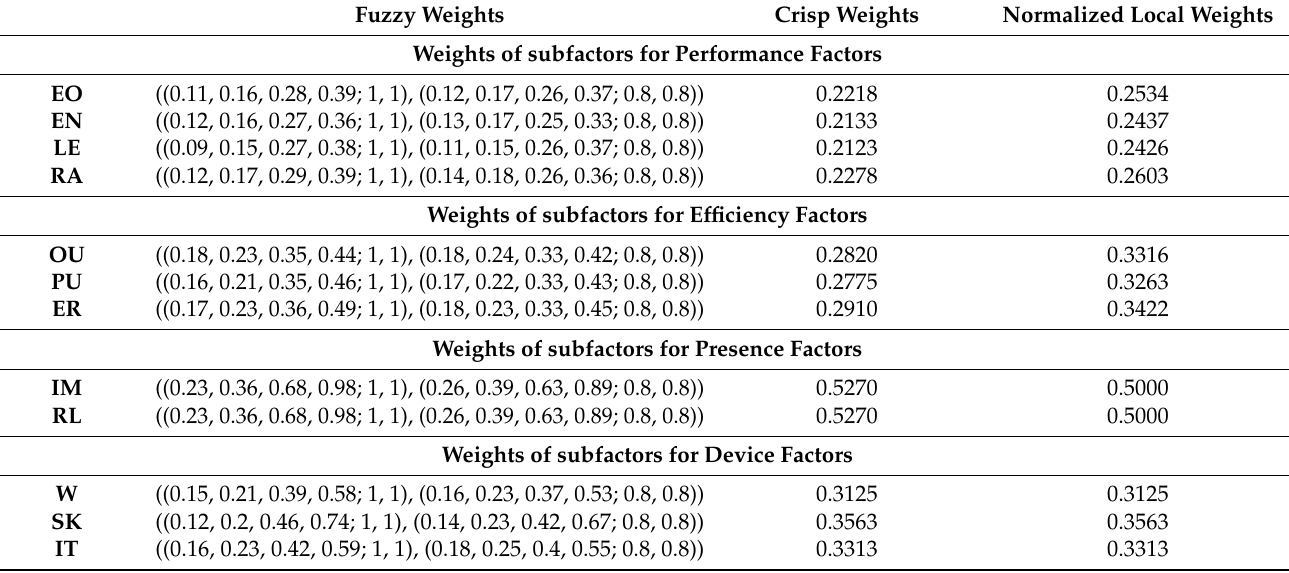
Table 8. Weights of subfactors.